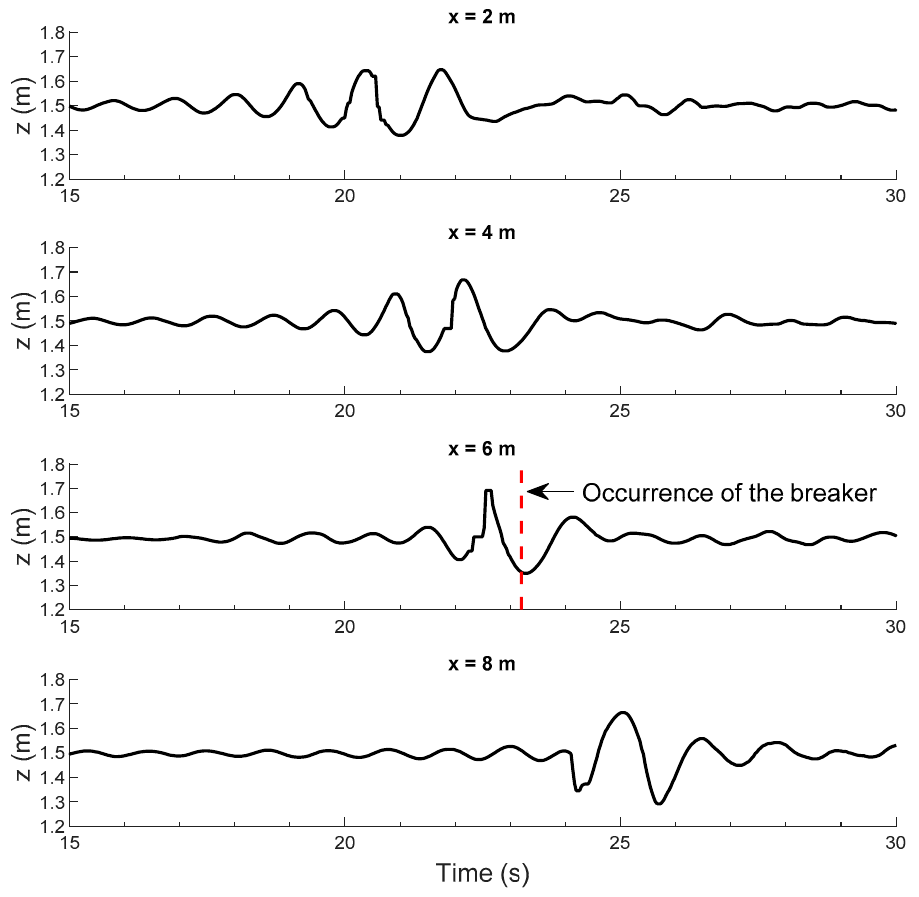
Figure 5. Temporal evolution of water elevations at four locations from the wavemaker. Note the increase of the wave steepness due to the focus of different wave components before the occurrence of the breaker.